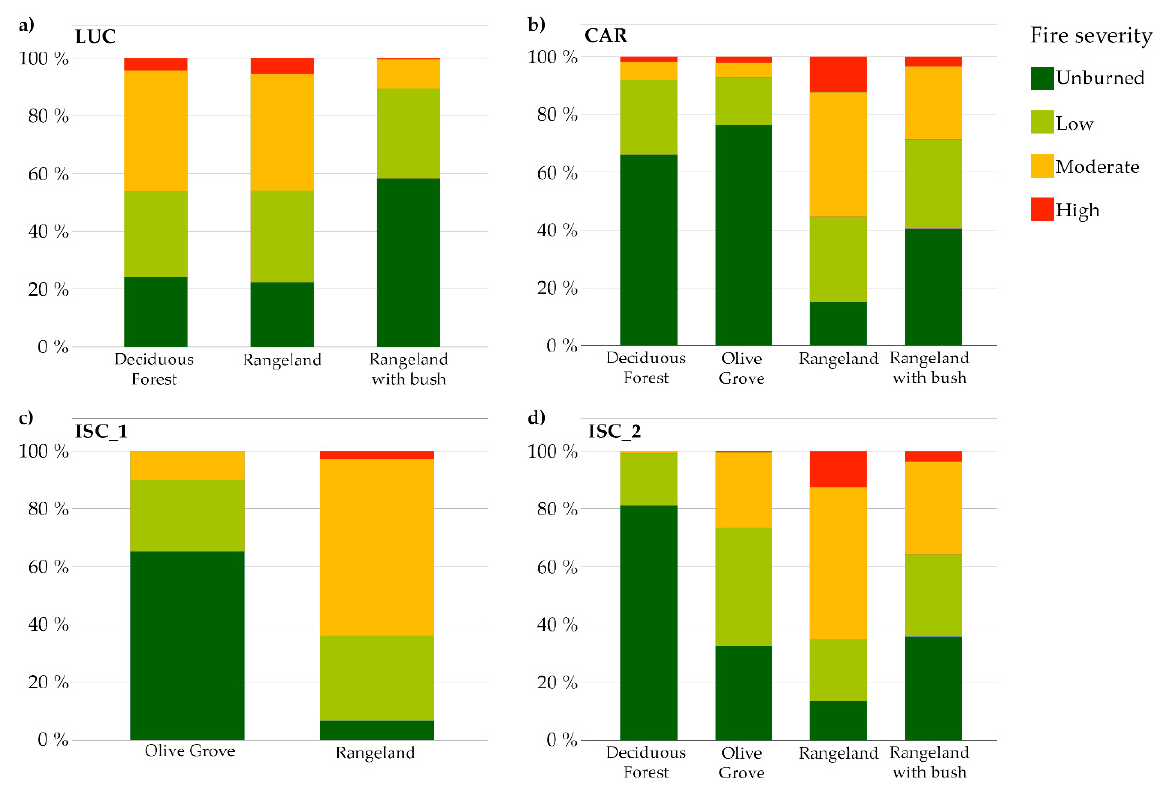
Figure 3. Areal percentage of fire severity class (high, moderate, low, and unburned) per land use within the study sites: ( a ) LUC, Lucera site; ( b ) CAR, Carpino site; ( c , d ) ISC_1 and ISC_2, Ischitella sites.